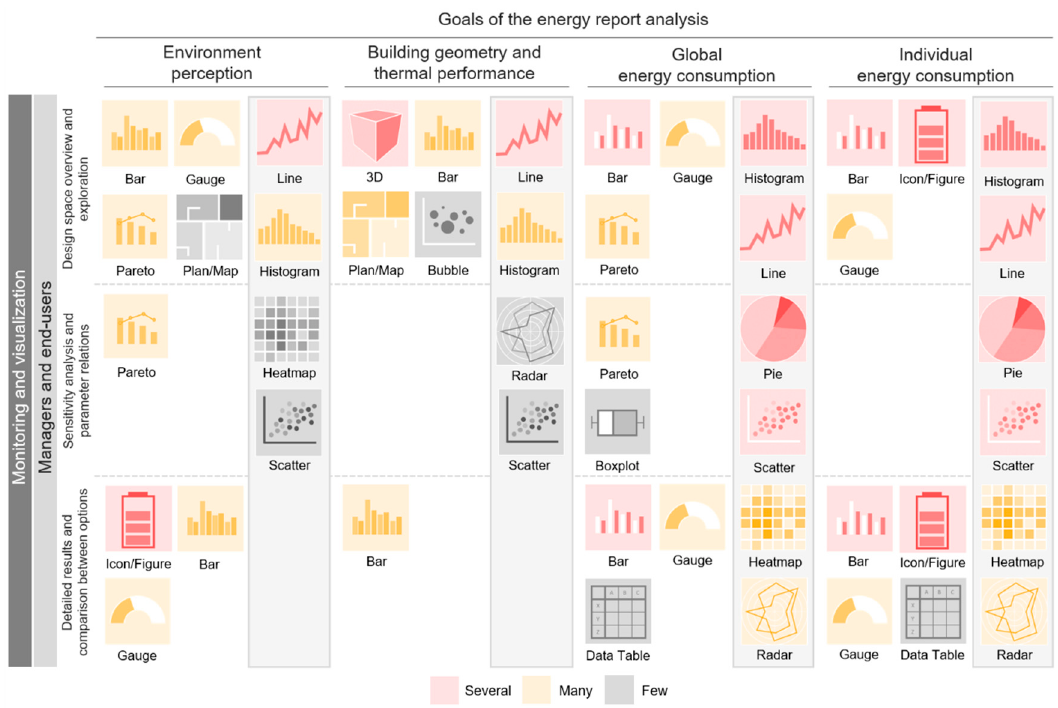
Figure 9. Graphical representations per goals and level of detail of data analysis for monitoring and visualization.